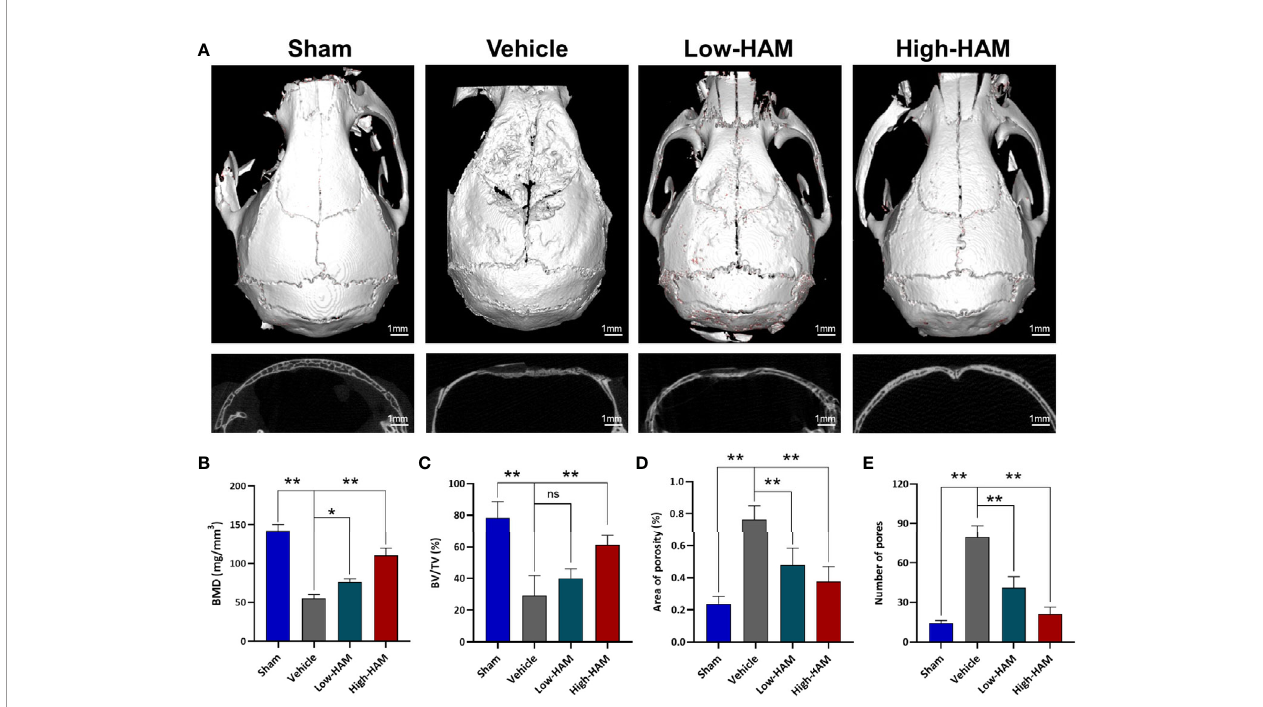
FIGURE 1 | Harmine alleviated Ti debris-stimulated osteolysis and bone loss. (A) Representative micro-CT 3D and 2D pictures of murine calvaria. Scale bar indicates 1 mm. Computations for (B) BMD, (C) BV/TV, (D) Area of porosity and (E) Number of pores. n = 3. All data were expressed as the mean ± SD, ns, no signi fi cance, * p < 0.05, ** p < 0.01, compared with the vehicle